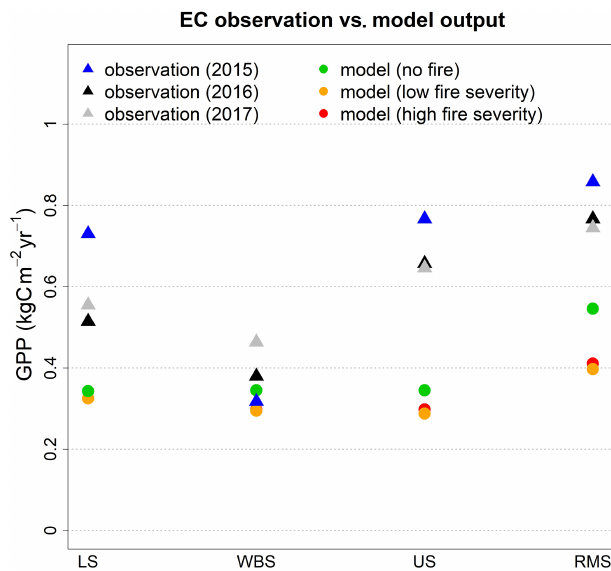
Figure 3. Comparison of simulated average annual GPP from EDv2.2 for alternative fire scenarios (no fire, low fire severity, and high fire severity) with observations (from 2015, 2016, 2017) from all four EC tower